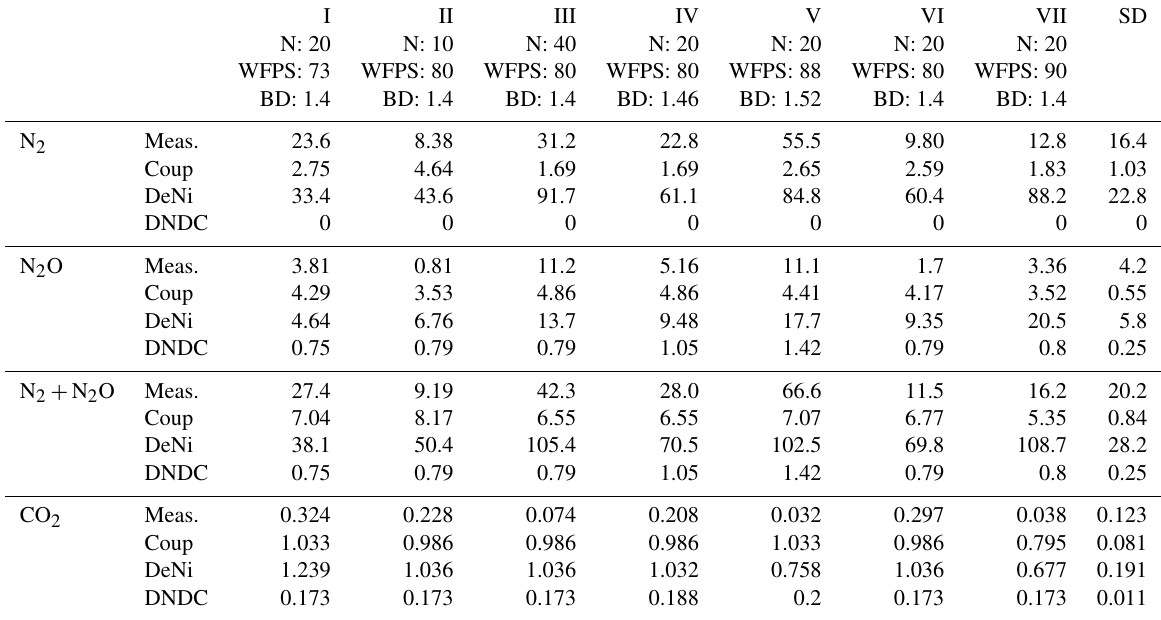
Table 3. Average measured (average of the five measurement events for 34d) and modeled (Coup, DeNi and DNDC models) N 2 , N 2